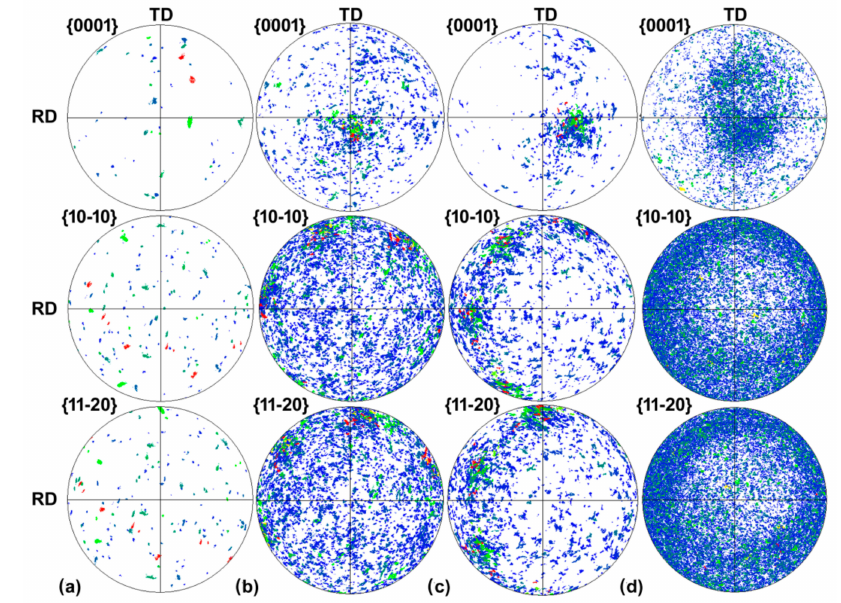
Figure 7. Pole figures emphasizing grains orientations in relation with grain growth for samples: RS-ST ( a ); RS + 400 RPM FSP ( b ); RS + 800 RPM FSP ( c ); RS + 1200 RPM FSP ( d ).